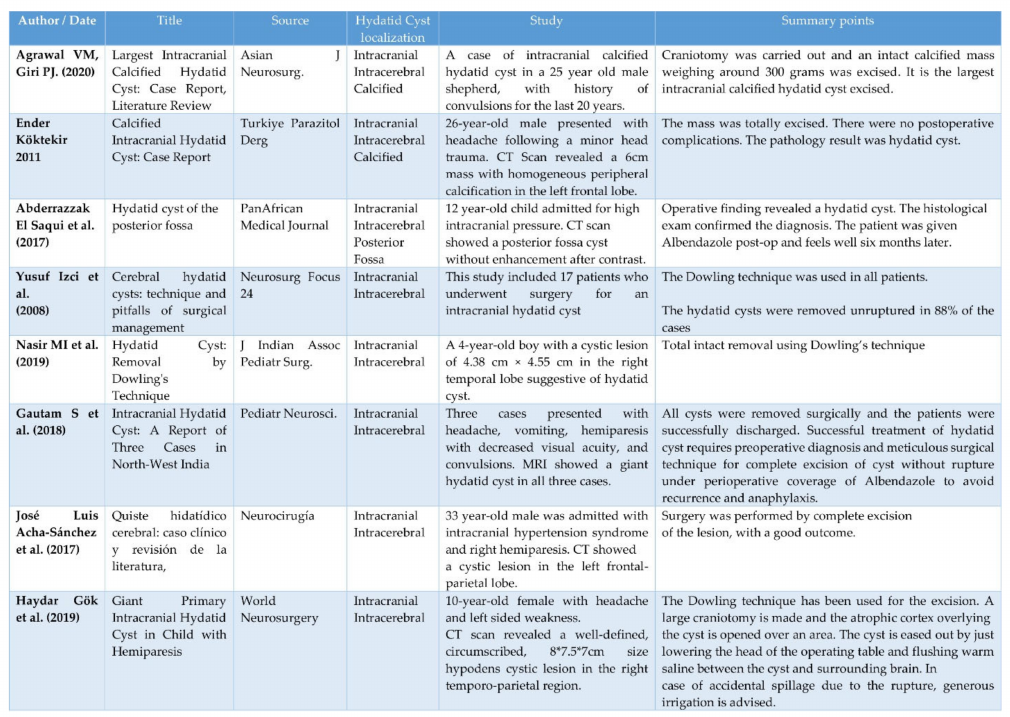
Figure A2. Articles review summary including reported cases that discuss intracranial-intracerebral hydatid